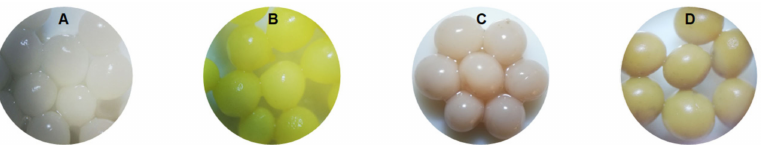
Figure 1. Photographs of synthesized biosorbents (( A , B )—SPA 5%; ( C , D )—SPRBA 5%) before ( A , C ) and after ( B , D ) biosorption of ethacridine lactate.